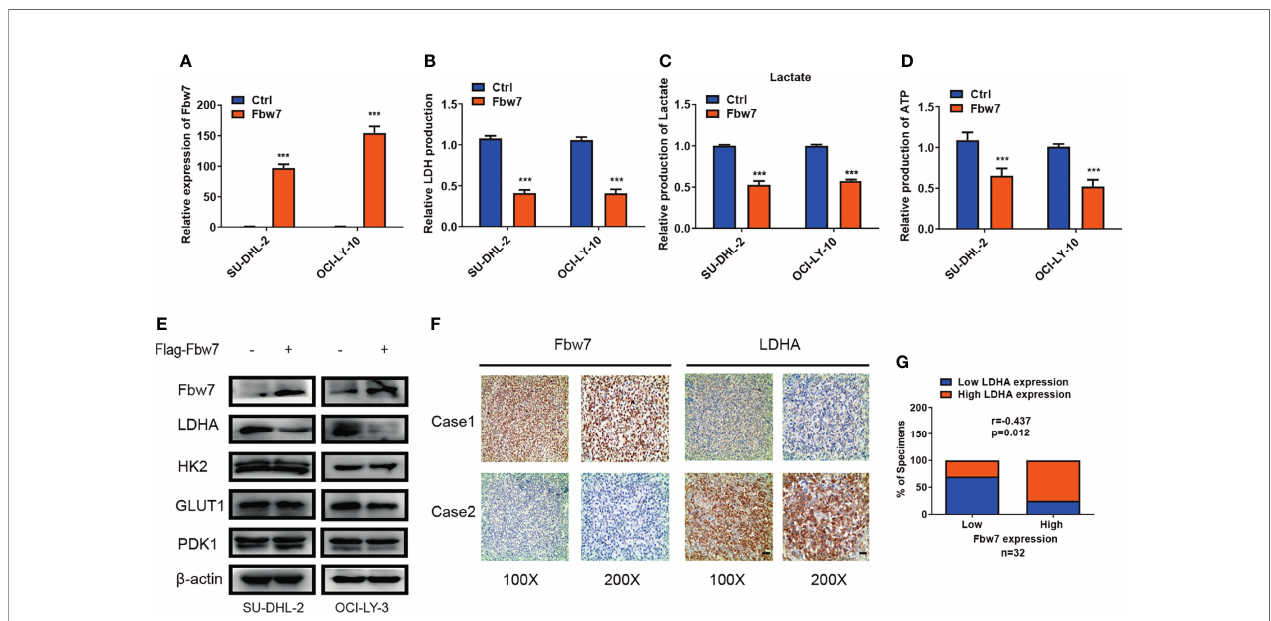
FIGURE 1 | Fbw7 impaired LDHA-mediated glucose metabolism reprogramming in ABC DLBCL. (A) QRT-PCR analysis of the relative mRNA expression in OCI-LY- 3 and SU-DHL-2 cell lines. Cells were transfected with Flag-Fbw7 and vector control to detect Fbw7 expression. The mean ± SD is shown for three independent experiments. ***P < 0.001; one-way ANOVA. (B) Fbw7 inhibited intracellular LDH in ABC-DLBCL cells. The mean ± SD is shown for fi ve independent experiments. ***P < 0.001; one-way ANOVA. (C) Fbw7 reduced intracellular lactate production in ABC-DLBCL cells. Results are presented as mean ± SD. ***P < 0.001; one-way ANOVA. (D) Fbw7 reduced ATP production. Results are presented as mean ± SD. ***P < 0.001; one-way ANOVA. (E) Western blotting results showed that overexpression of Fbw7 mainly inhibited LDHA expression in Glycolysis relative proteins. And the expression of Fbw7, LDHA, HK2, GLUT1, PDK1 were shown. (F) IHC staining results of Fbw7 and LDHA were shown with representative images from the same tumor case. The scale bar of “ 100x ” indicates for 100 m mand the scale bar of “ 200x ” indicates for 50 m m. (G) spearman correlation analysis between Fbw7 and LDHA in DLBCL FFPE tissues. Spearman rank correlation. P < 0.05 was considered to indicate a signi fi cant